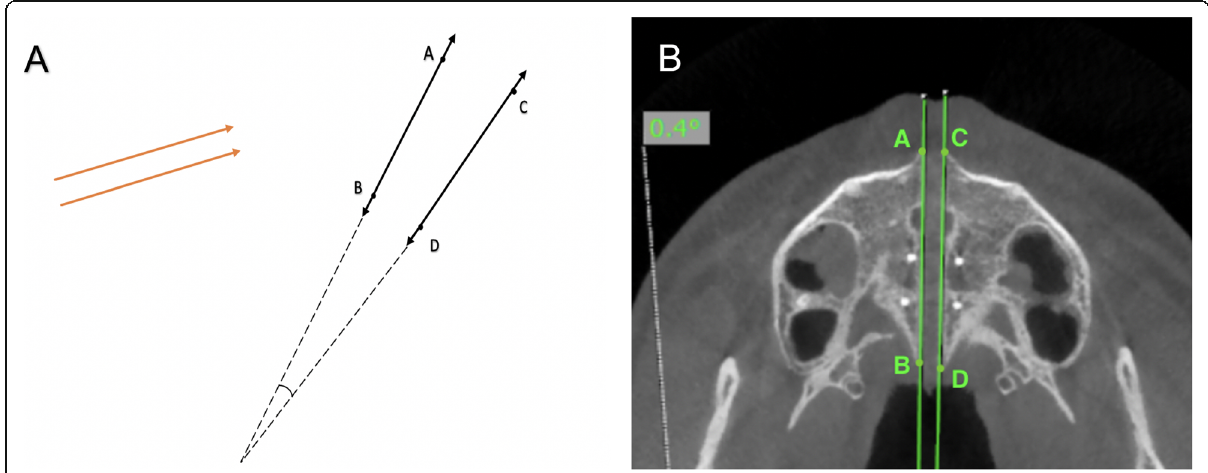
Fig.6 a Two parallel lines, in the same plane, form 0°; two non-parallel lines converging at an angle. b AB and CD lines are intersecting in a distant point with 0.4°. AB represents right palatal line, and CD represents left palatal line